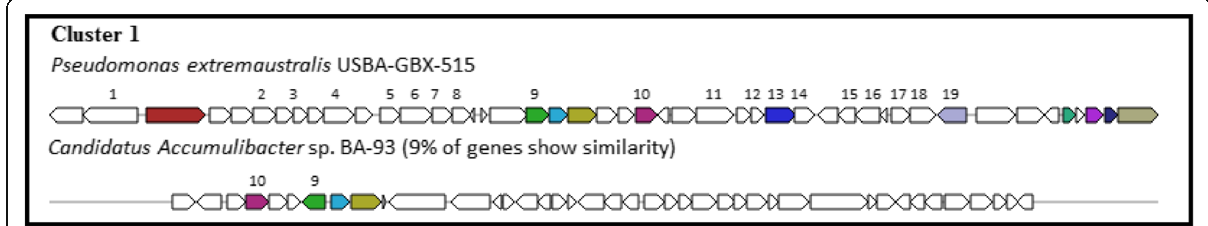
Fig. 5 Genetic map of lipopolysaccharide biosynthetic gene cluster 1 detected by AntiSMASH 3.0. The genes were designated by colors. Same color means equal genes in different strains, not-colored means other genes. 1. pyruvate dehydrogenase subunit E1; 2. UDP-glucose:(heptosyl) LPS alpha 1,3-glucosyltransferase WaaG; 3. hypothetical protein PA5008; 4. Serine/threonine protein kinase; 5. sugar ABC transporter substrate- binding protein; 6. ABC transporter ATP-binding protein; 7. bifunctional carbohydrate binding and transport protein; 8. bifunctional carbohydrate binding and transport protein; 9. glycosyl transferase family protein; 10. glycosyl transferase family protein; 11. lipid A export permease/ATP-bind- ing protein MsbA; 12. adenylyl-sulfate kinase; 13. bifunctional heptose 7-phosphate kinase/heptose 1-phosphate adenyltransferase; 14. Epimerase; 15. hypothetical protein PA4992;16. FAD-dependent oxidoreductase; 17. transcriptional regulator; 18. hypothetical protein PA4974; 19. 3-deoxy-D- manno-octulosonic acid transferase